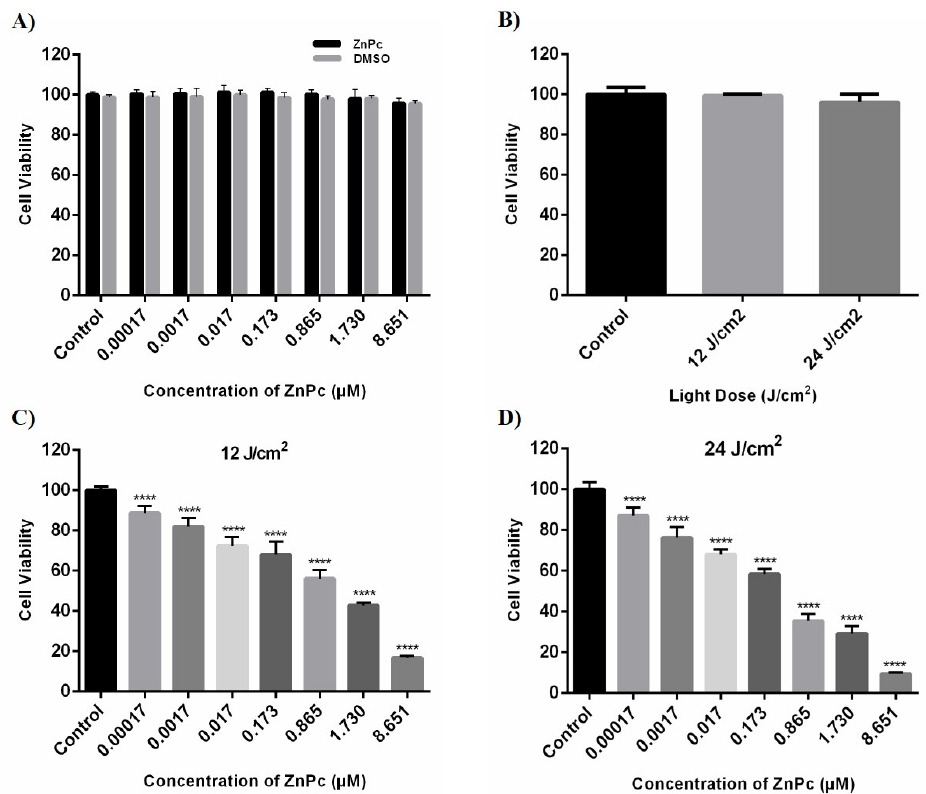
Figure 2. The cytotoxic effects of ZnPc, DMSO, light dose, and ZnPc-PDT were determined at 24 h after treatments by MTT assay and nonlinear regression on SW480 cells. ( A ) The percentage of cell viability in the presence of different concentrations of ZnPc and DMSO (without irradiation). ( B ) The percentage of cell viability after different irradiations of light dose (without ZnPc; 12 and 24 J/cm 2 irradiation). ( C ) The percentage of cell viability after ZnPc-PDT with 12 J/cm 2 irradiation. ( D ) The percentage of cell viability following ZnPc-PDT with 24 J/cm 2 irradiation. The results are expressed as mean ± SD ( n = 3); **** p < 0.0001 versus Table 1. IC50 values of ZnPc-PDT in different doses of the light dose.